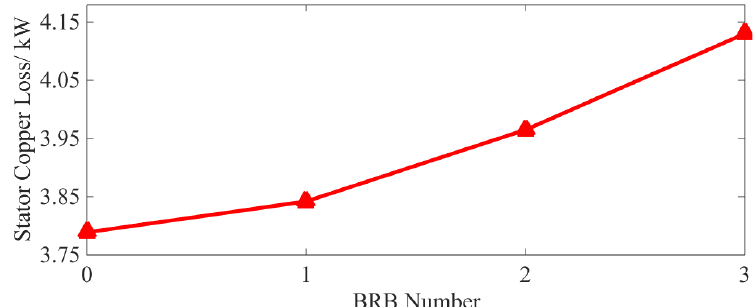
Figure 9. Characteristic curve of stator copper loss.